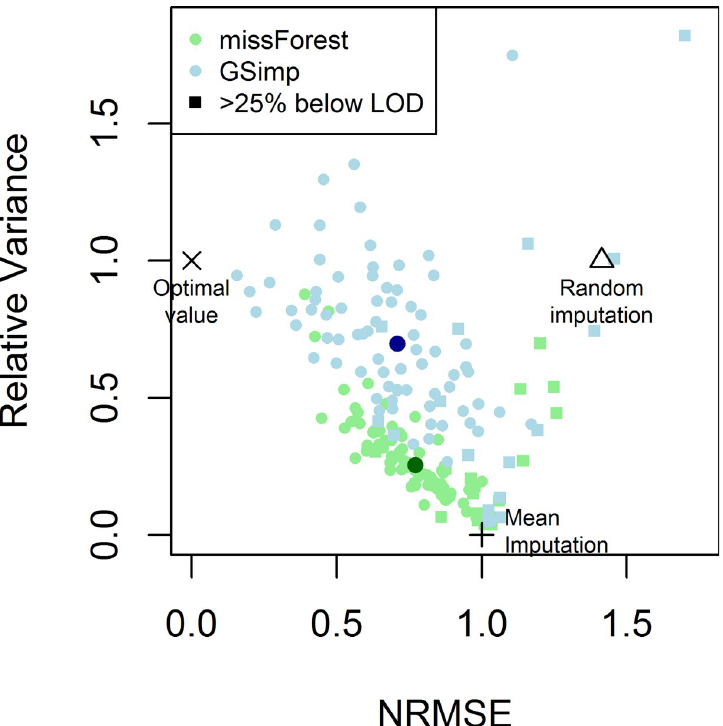
Fig 4. MissForest vs. GSimp. Evaluation of imputation accuracy based on the NRMSE and relative variance for 91 proteins imputed with the imputation algorithms missForest (green dots) and GSimp (blue dots). Large dots represent the respective median value. Squares denote proteins with more than 25% of values below LOD. GSimp results were closer to the optimal value and outperform mean and random imputation for most proteins.